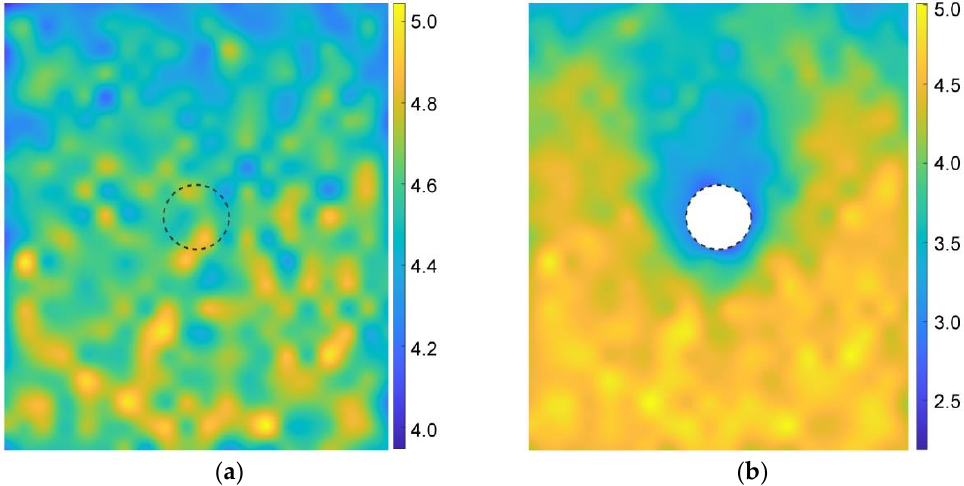
Figure 16. Distribution of coordination numbers of the sandy ground ( a ) before and ( b ) after the tunnel excavation.